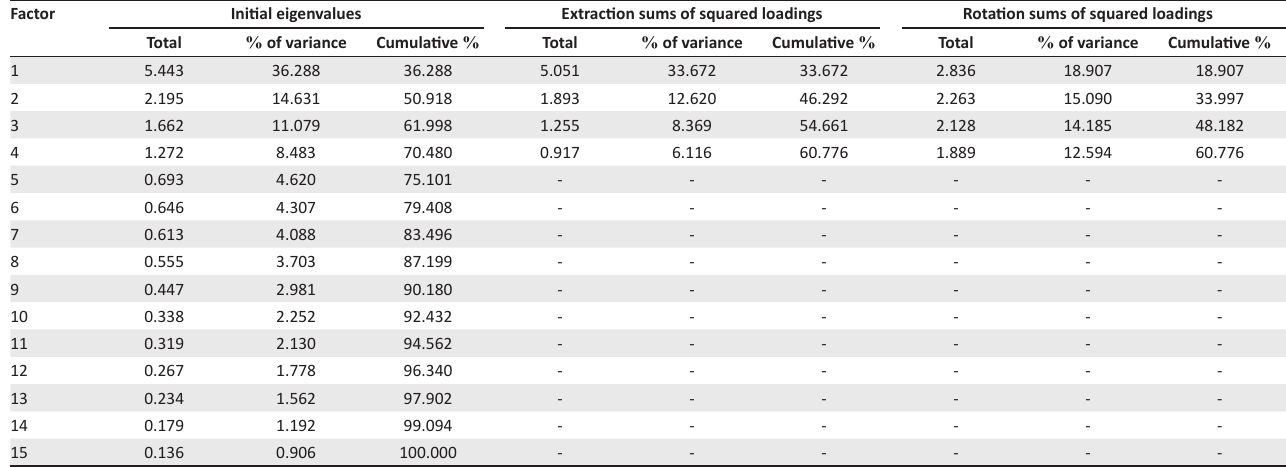
TABLE 4: Total variance explained by extracted factors. Factor